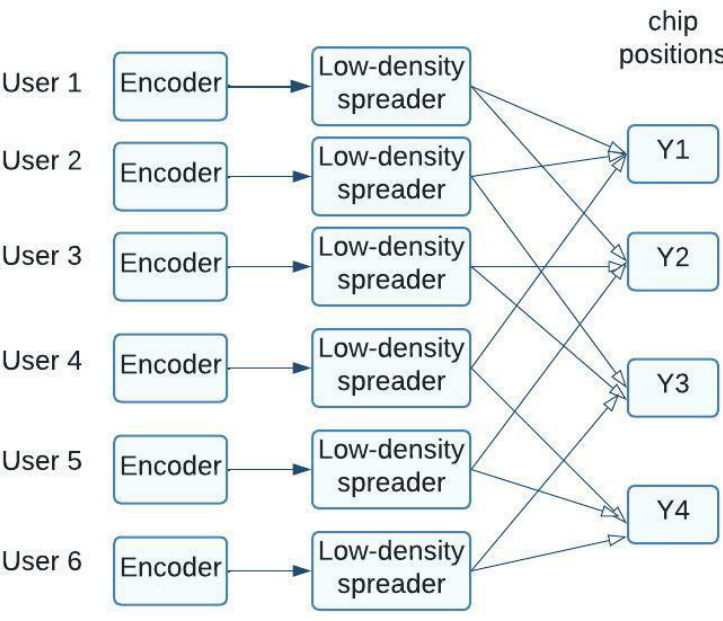
Figure 2. Illustration of an LDS–CDMA system’s basic architecture.